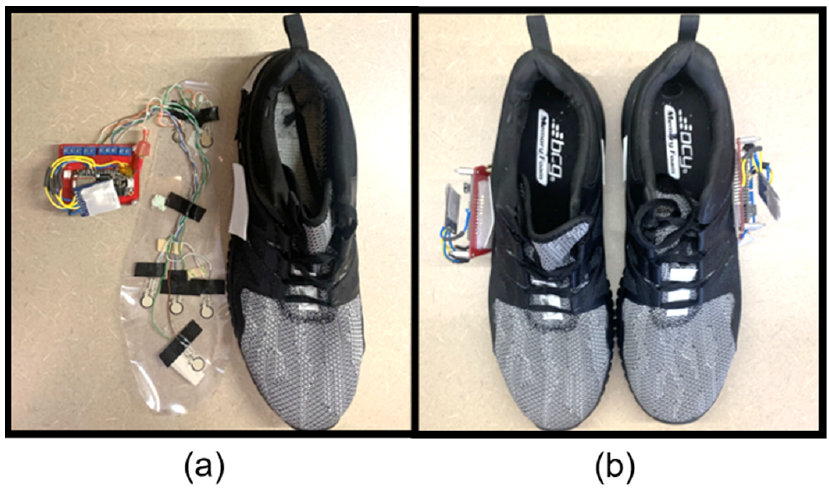
Figure 3. Complete footwear sensor system for men: ( a ) men’s size 10.5 with P2S2s and ( b ) a pair of shoes assembled for testing.